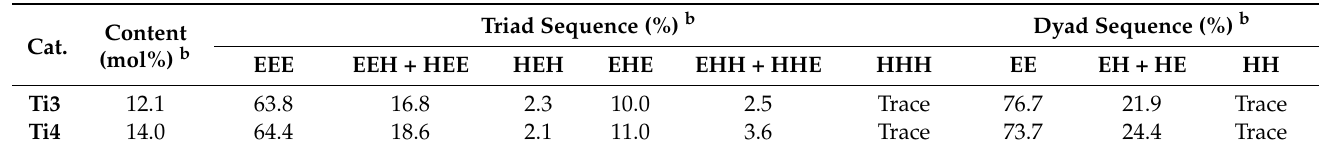
a Polymerization: see Table 2. b Calculated by 13 C NMR